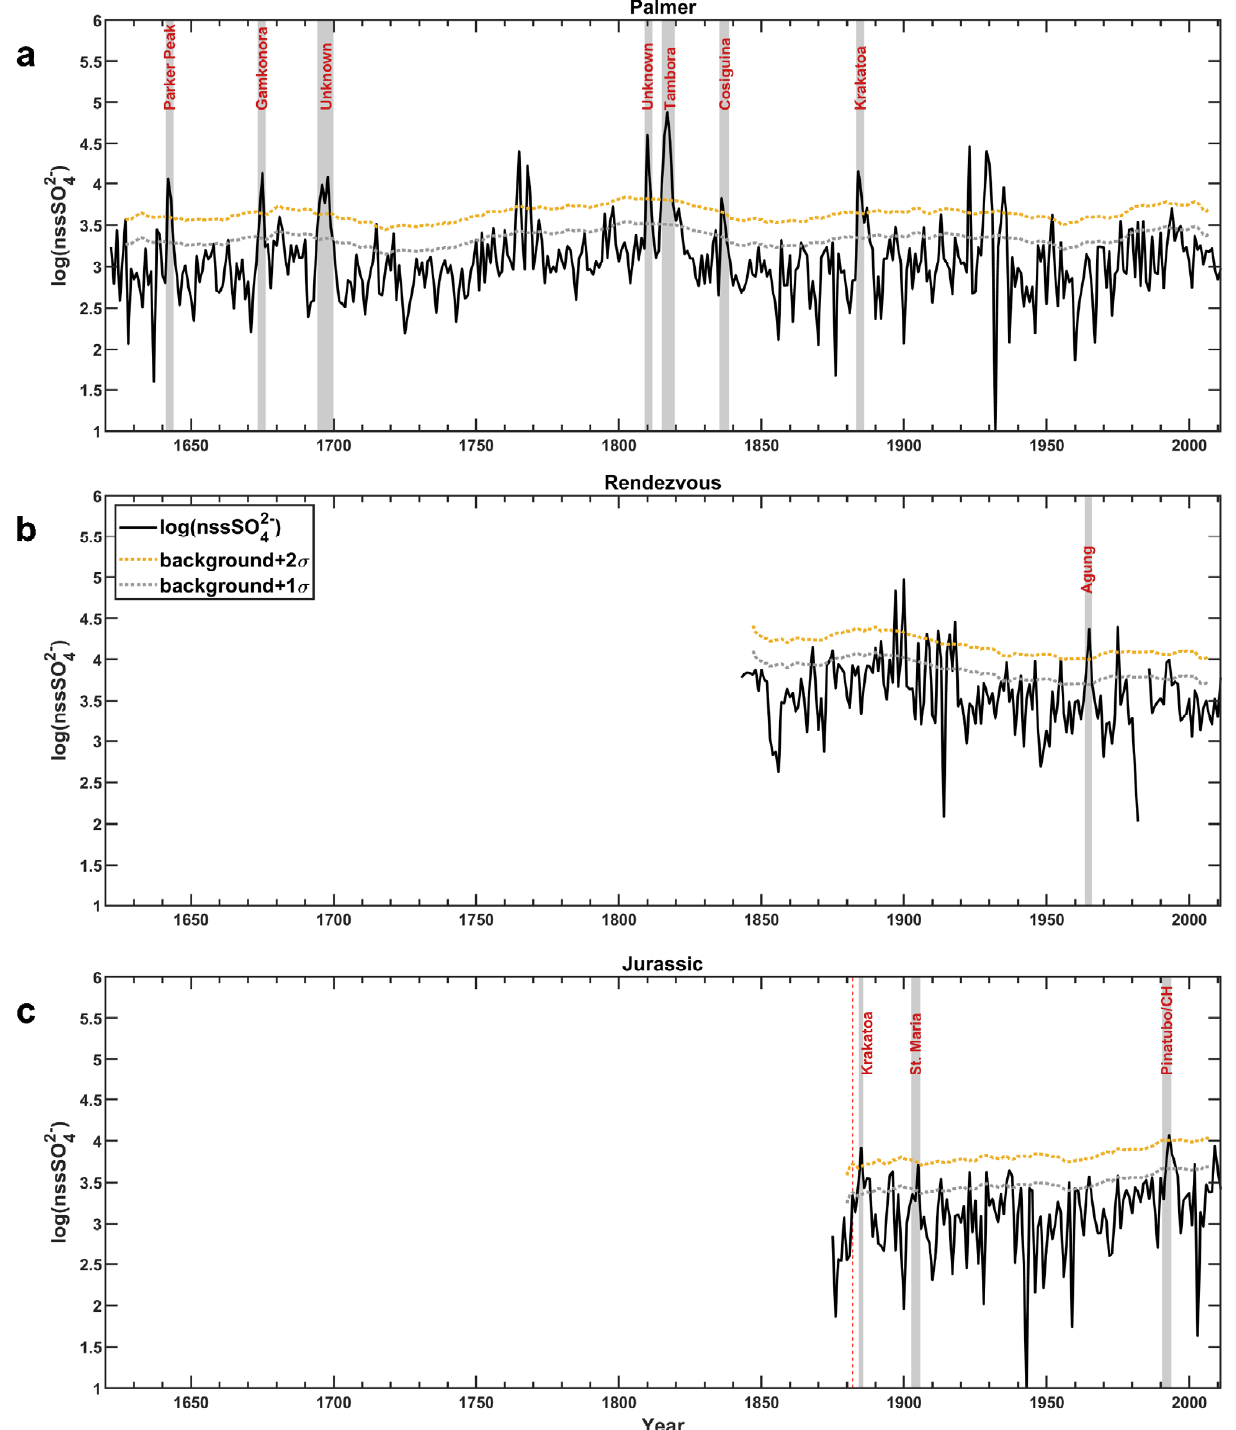
Figure 4. The log-normal of the annually averaged non-sea-salt sulfate records ([nssSO 42 − ], black line) for ( a ) Palmer, ( b ) Rendezvous, and ( c ) Jurassic. Grey shading indicates volcanic events [log([nssSO 42 − ]) ≥ background + 2 σ ]. The indicated events are bipolar events that have been identified in the WAIS divide and NEEM cores [nssSO 42 − ] records [32]. The dashed red line in c indicates the period (1874–1882) for which the log([SO 4 2 − ] − 0.251*average([Na + ])) record is displayed for Jurassic. The Pinatubo and Cerro Hudson (CH) eruptions occurred almost simultaneously in 1991, and they are therefore not separable in ice core SO 4 2 − records